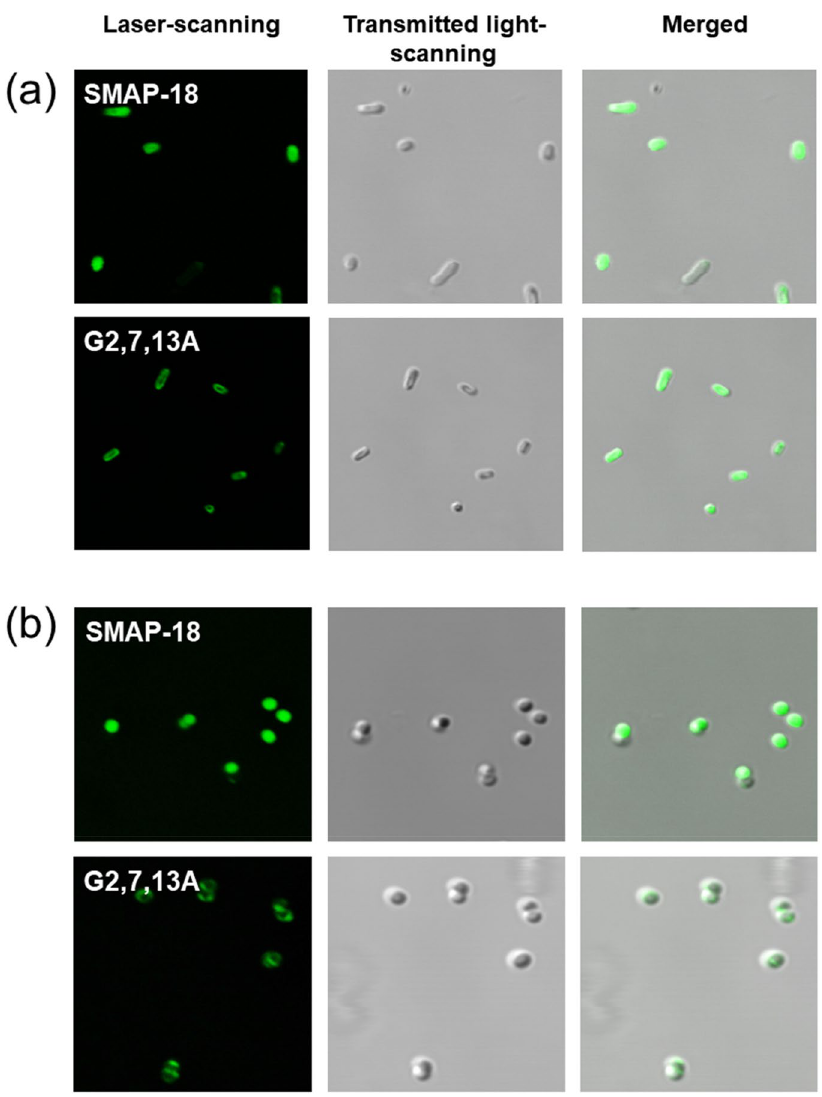
Figure 7. Confocal laser scanning microscopy of E. coli ( a ) and S. aureus ( b ) treated with FITC-labeled